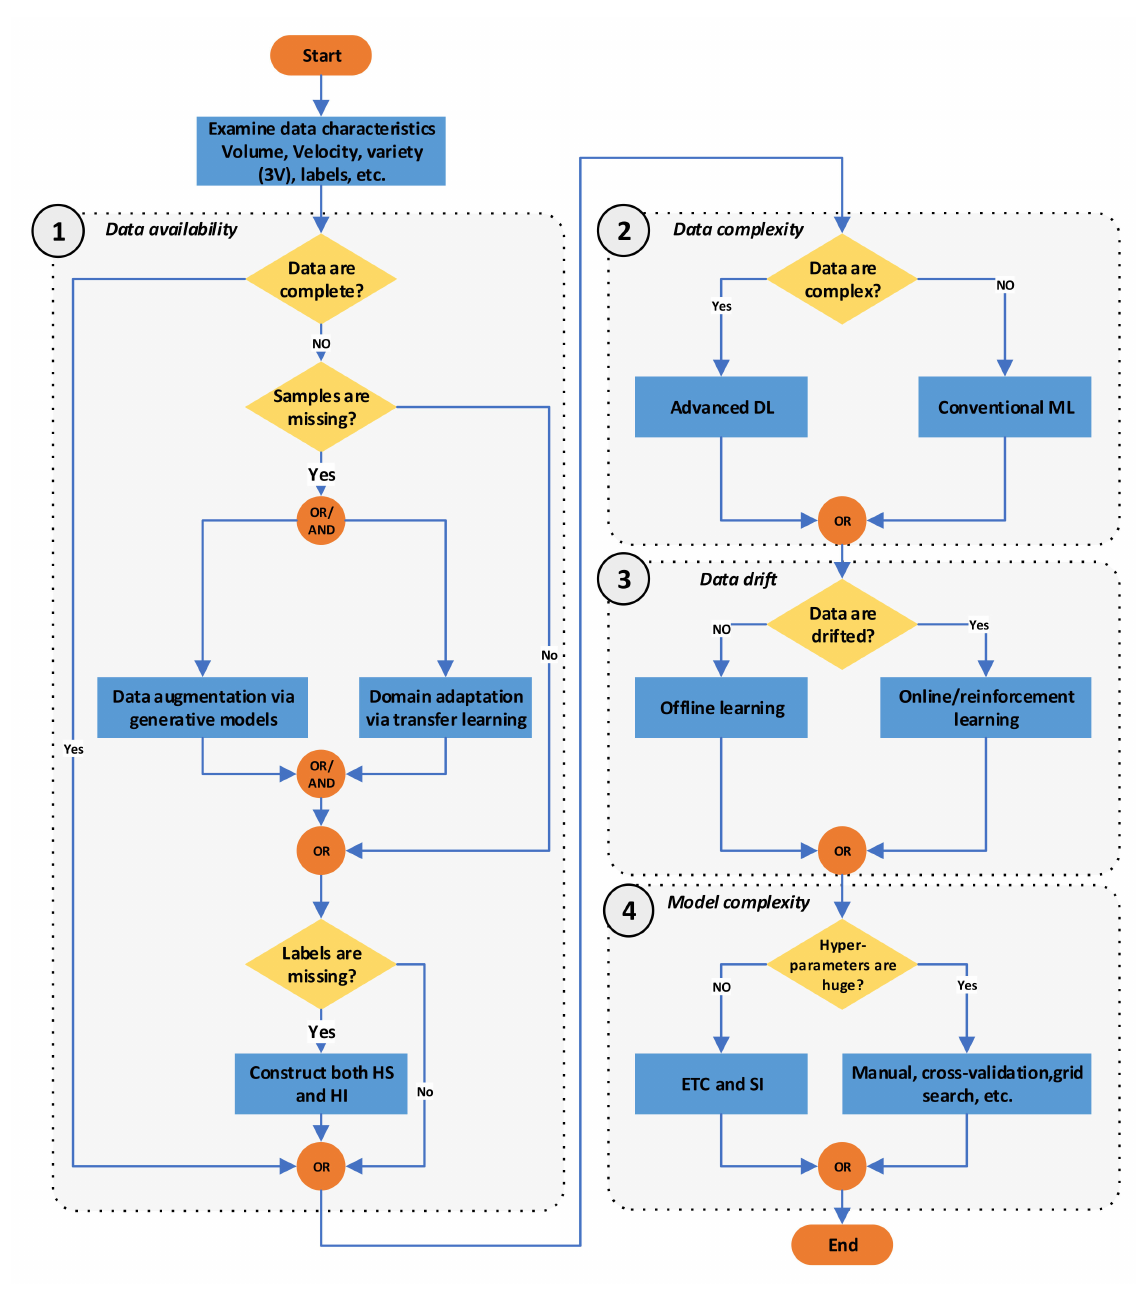
Figure 2. ML model selection methodology for RUL